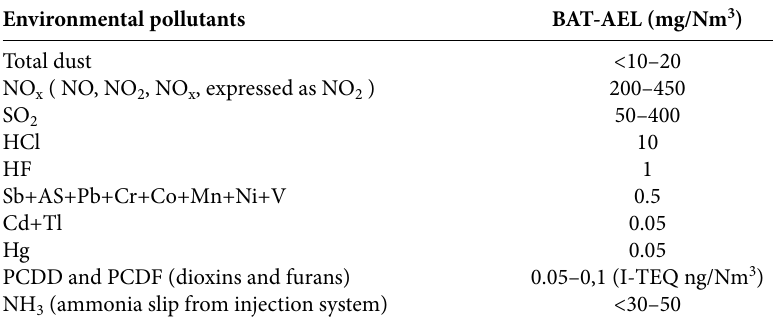
Table 1 . The BAT-AEL are 24-hour average values referred to dry gas in standard conditions (0 °C, 100 kP) and 10 %